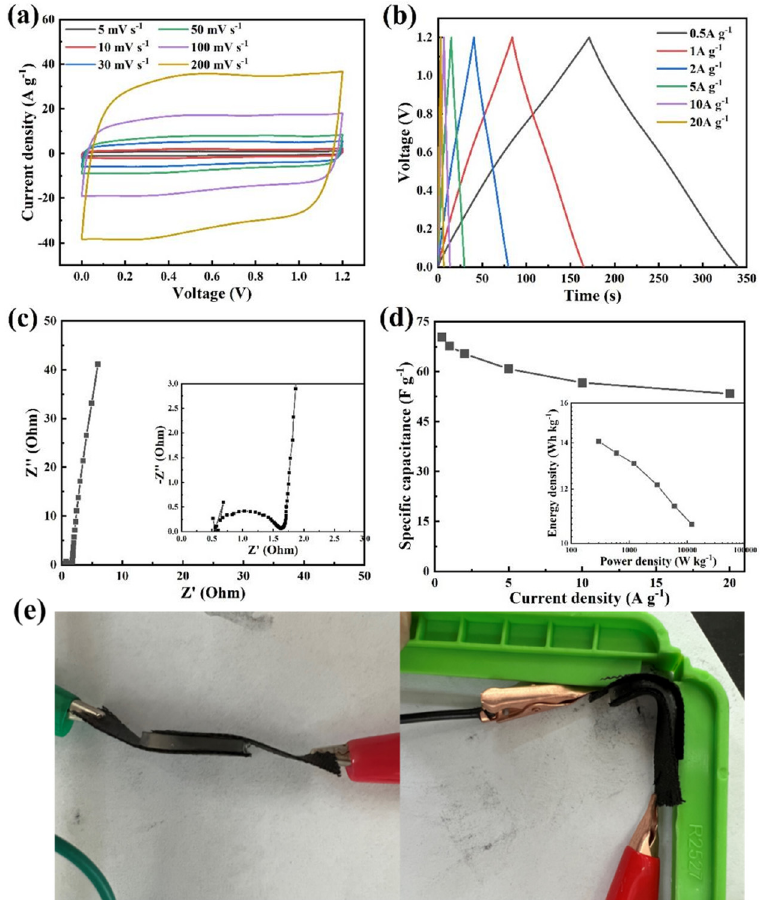
Figure 7. ( a ) CV curve, ( b ) GCD curve, ( c ) EIS curve; and ( d ) specific capacitance-current density curve (inset is power density-energy density curve) of hydrogel supercapacitor when bent at 90°. ( e ) Test digital photos when unbent and bent at 90°.